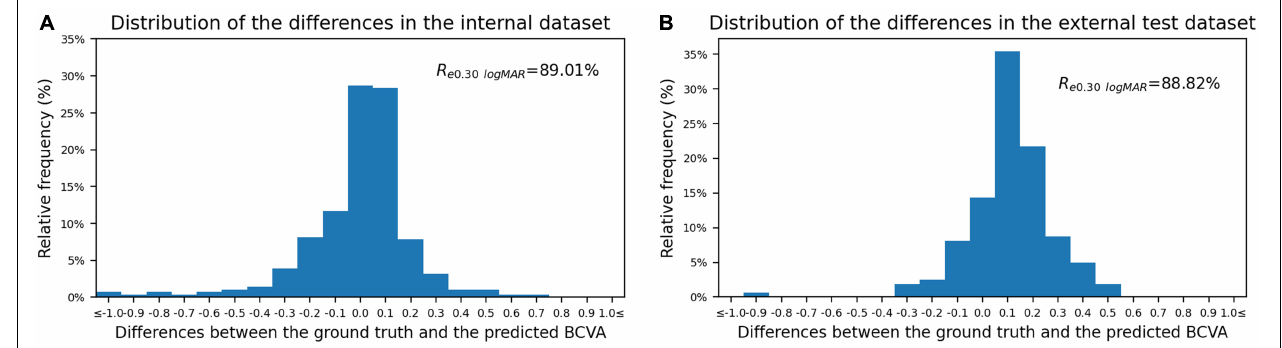
FIGURE 4 | The distribution of the difference between the predicted BCVA and the actual BCVA (ground truth) in the internal (A) and external (B) test datasets. All values were provided in logMAR units. The vertical axis indicates the relative frequency of each BCVA delta value. BCVA, best corrected visual acuity; logMAR, logarithm of the minimum angle of resolution; R e 0 . 30 logMAR , the percentage of BCVA prediction errors within ± 0.30